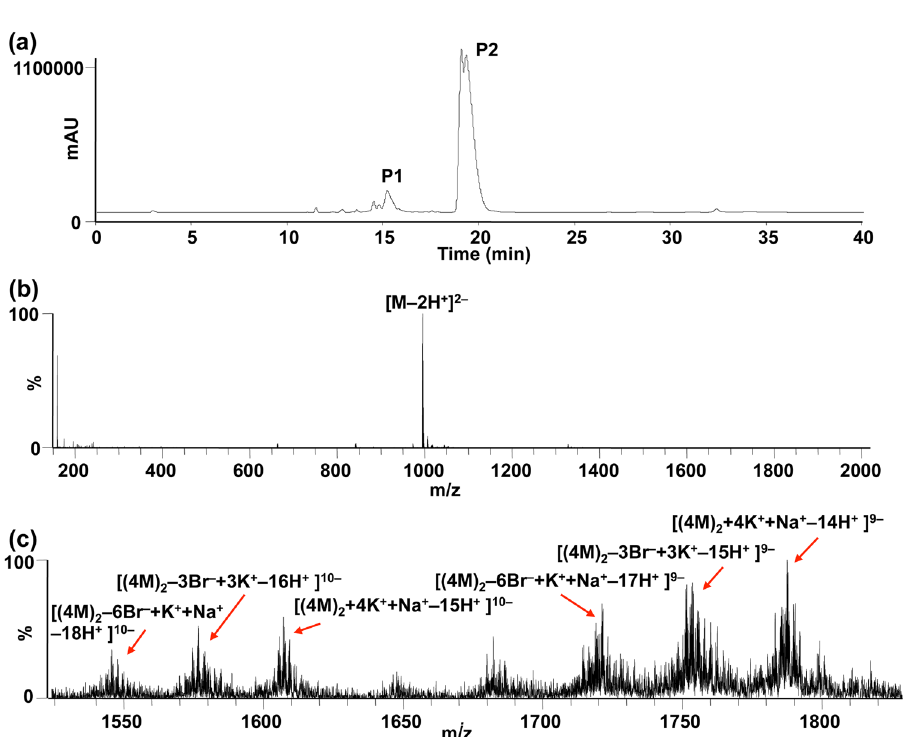
Figure 5. ( a ) LC analysis result of ORN-2. UV absorbance is monitored at 254 nm. ( b ) ESI-MS spectrum of P1 peak in LC. ( c ) ESI-MS spectrum of P2 peak in LC. Molecular ions (9 – and 10 – ) are directly observed for dimer G-quadruplex by electrospray ionization MS. Sample concentration is 0.05 mM. M: molecular